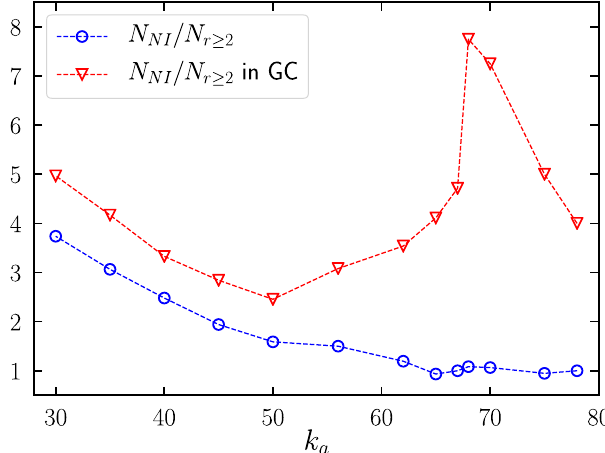
=N FIG. 3. Ratio N between the two terms in Eq. (13) r ≥ 2 NI 3 , and size evaluated on UCM networks with γ ¼ 4 , k min ¼ N ¼ 10 7 , computed over all nodes, and restricted to nodes belonging to the